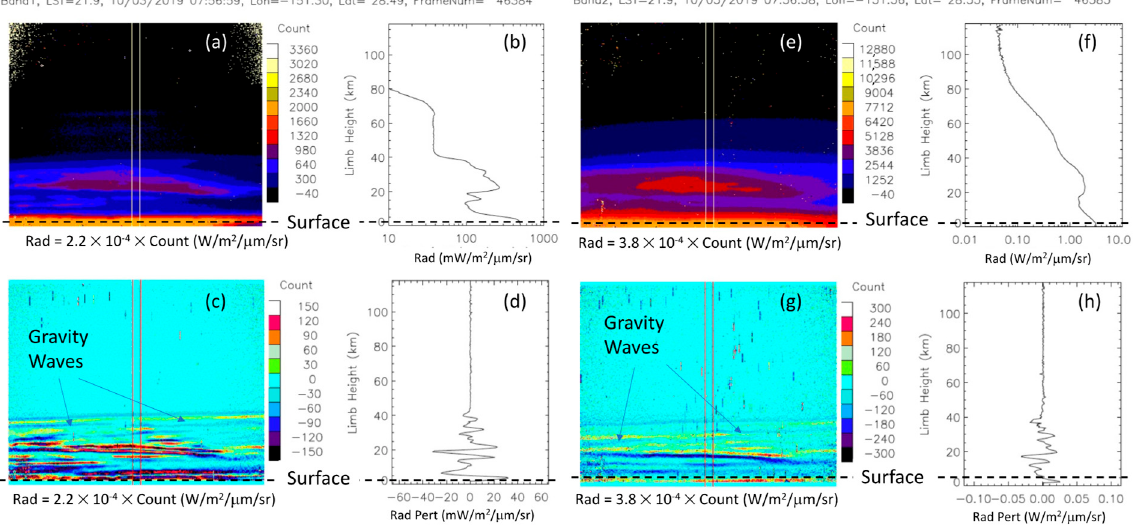
Figure 5. As in Figure 4, but from 3 October 2019 at LST = 21.9 h. In this case, both band1 ( a – d ) and band2 ( e – h ) limb observations are available, but their acquisition times differed by ~1.2 s. Similar GW structures were observed in the band1 ( c , d ) and band2 ( g , h ) radiance perturbations.